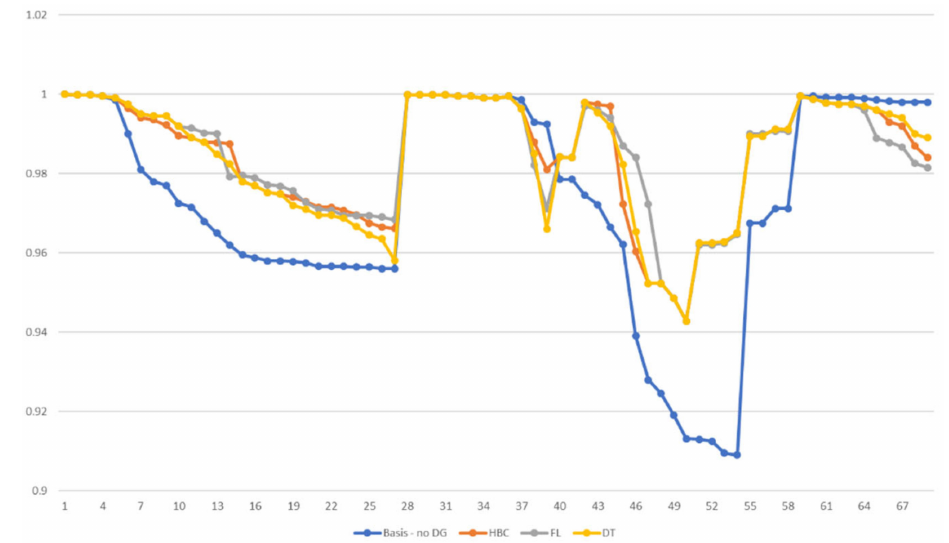
Figure 4. Case of no distributed generation. Voltage profile. Base case (blue); Hysteresis Band Control method (orange); control by means of Fuzzy Logic (grey); Decision Trees method (yellow).